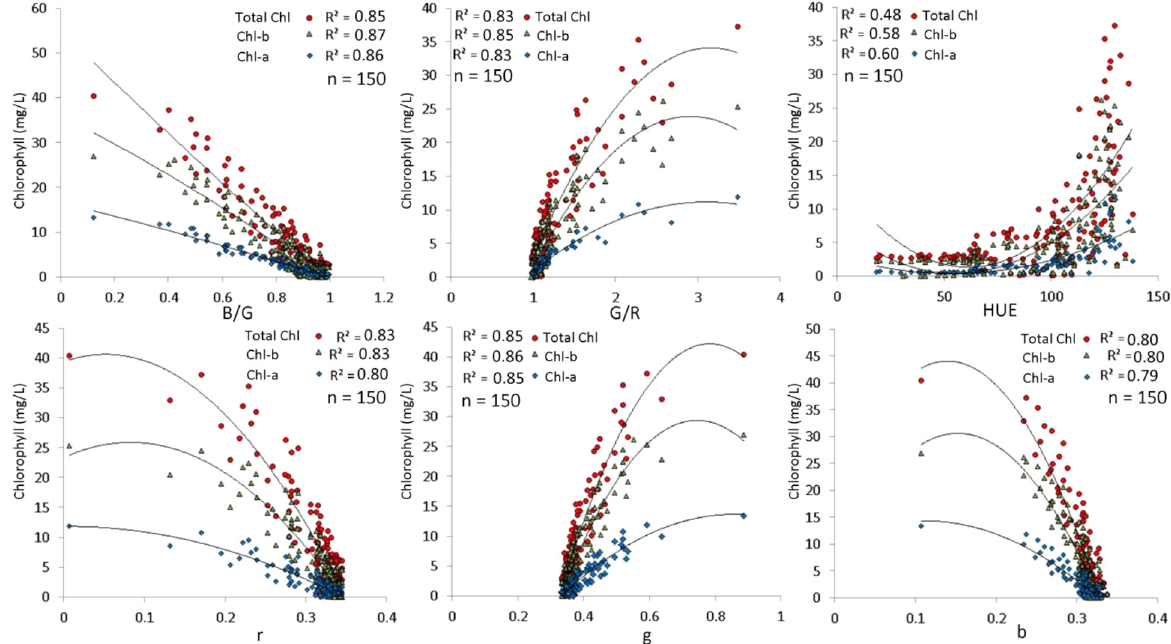
Fig. 6. Relationship between chlorophyll contents in chlorophyllin and indices.